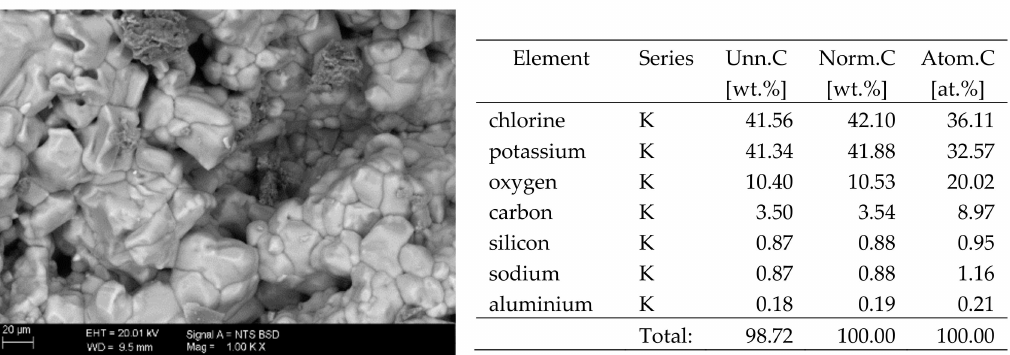
Figure 4. SEM image of the microstructure of MgCl 2 crystals visible on the surface of the bricks tested; 1000 × magnification. Next to it is a screenshot an EDS analysis for presence of crystals.